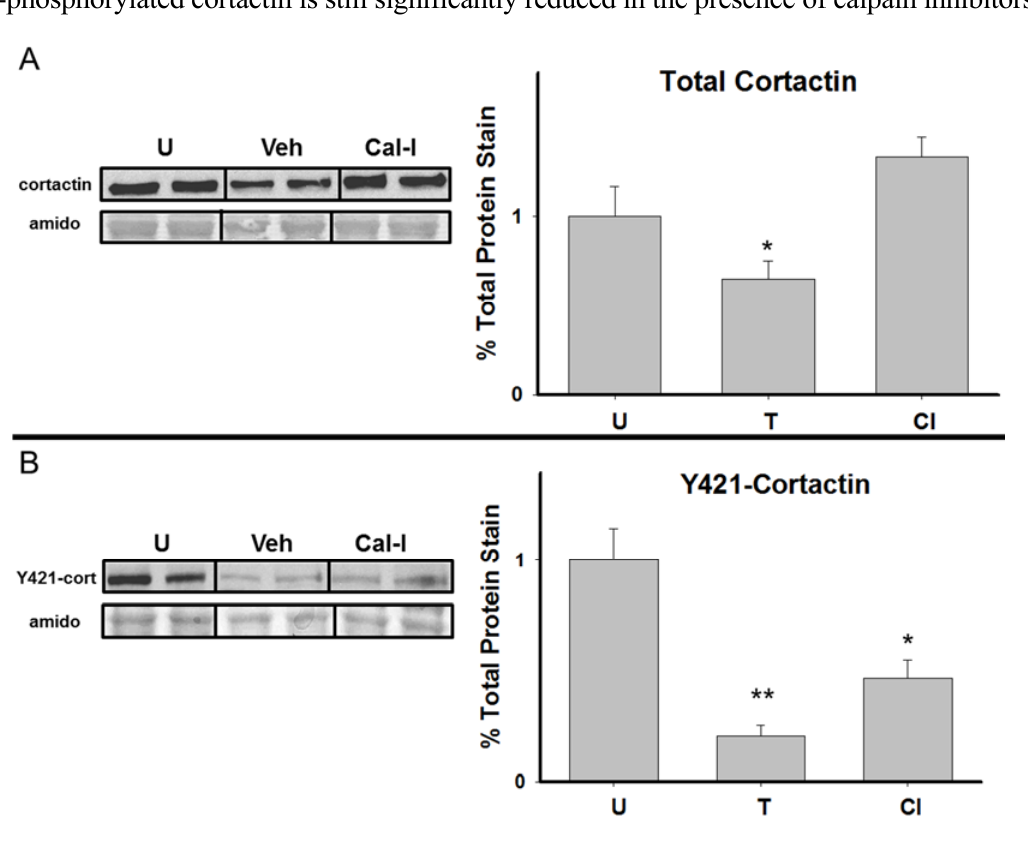
Figure 5. Chronic calpain inhibition blocks the reduction in total, but not Y421-phosphorylated cortactin following spatial working memory formation in the RAM. Representative samples and graphical depictions of group means for hippocampal total, and Y421-phosphorylated, cortactin (±SEM; expressed as percent of untrained controls) at 30 min following RAM training for Veh and Cal-I groups. * p < 0.05 compared to untrained controls, ** p < 0.05 compared to both untrained control and Cal-I